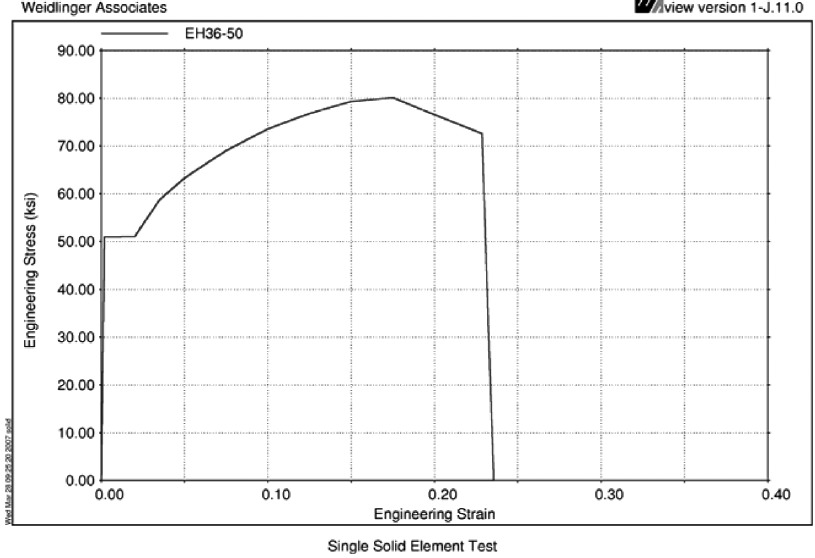
Fig. 8. Engineering stress-strain curve for EH36-50 steel used in the fi nite element